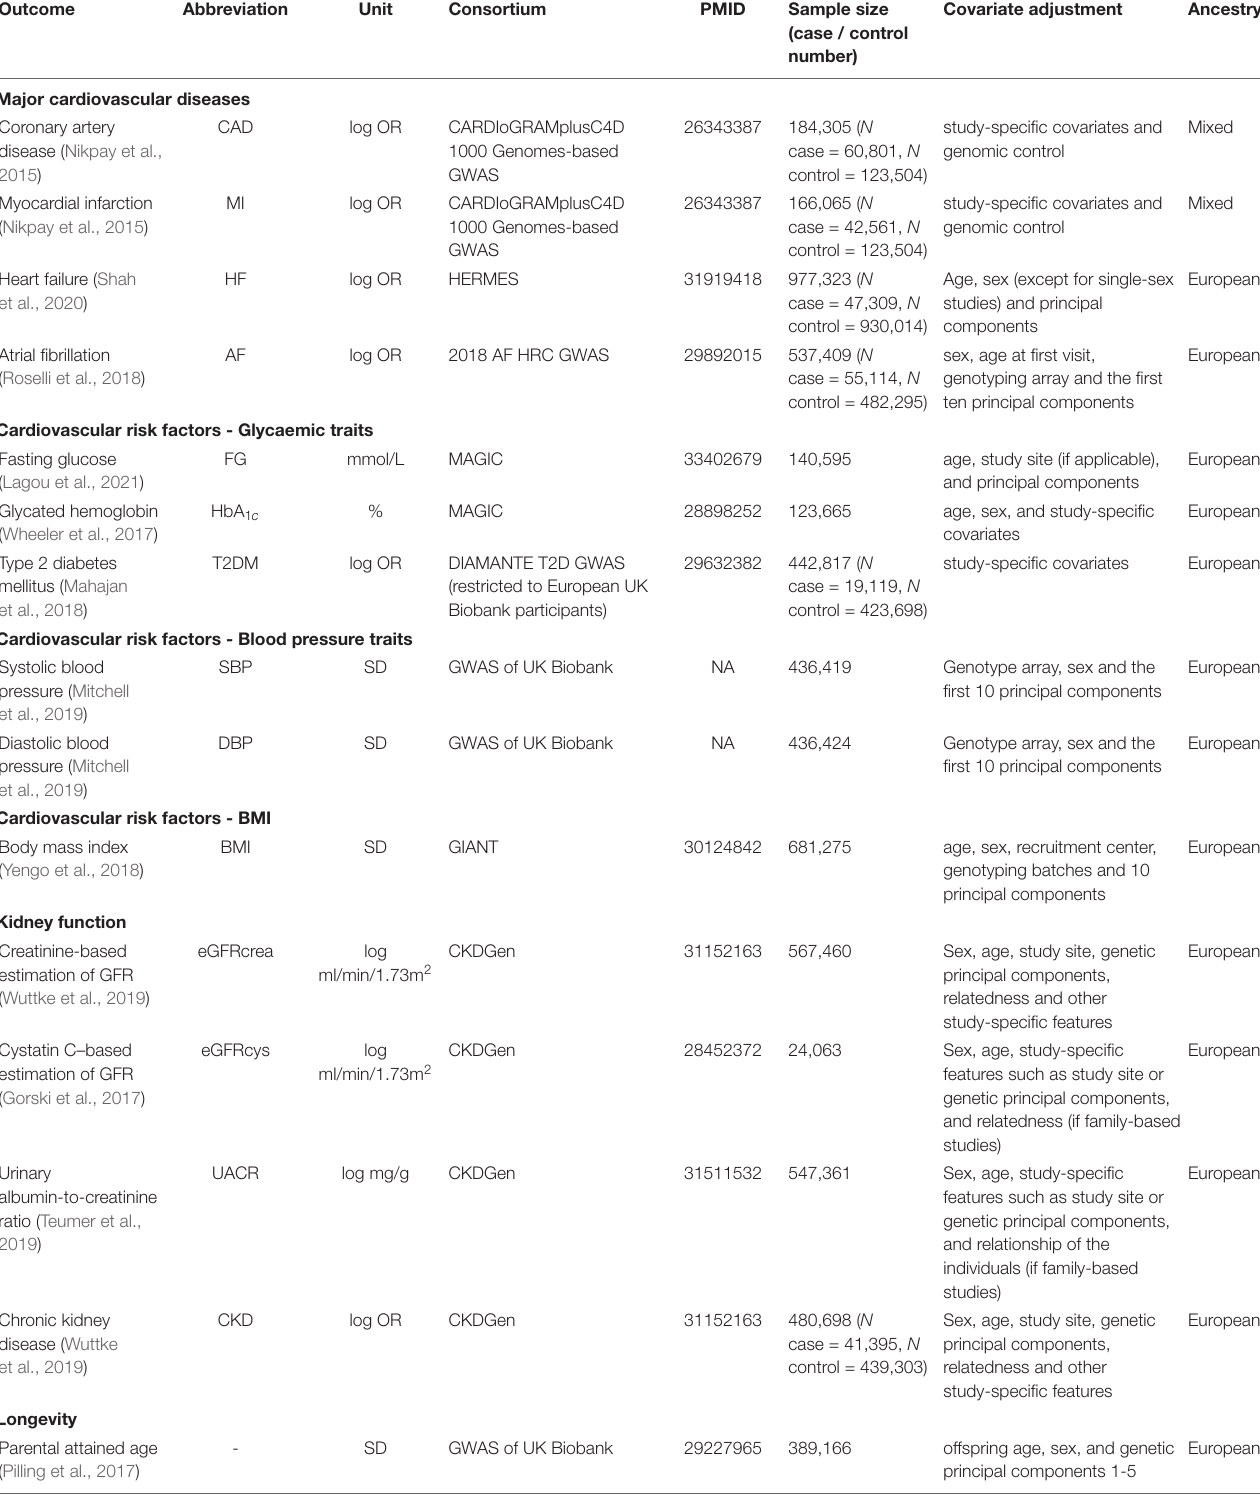
TABLE 1 | Information of outcomes included in the